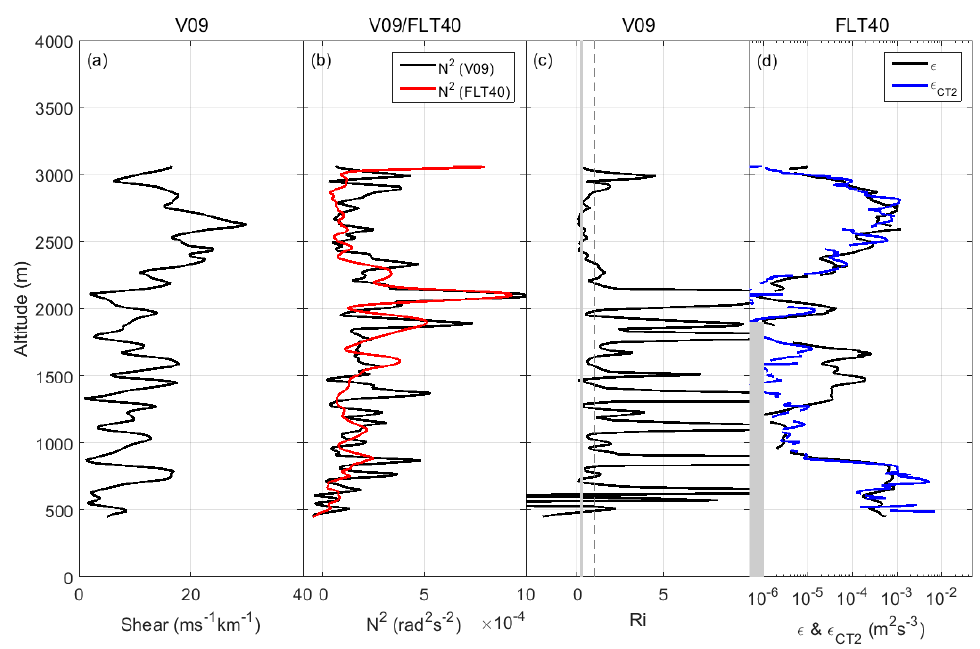
Figure 16. The same as Figure 15 for V09 and FLT40A1.